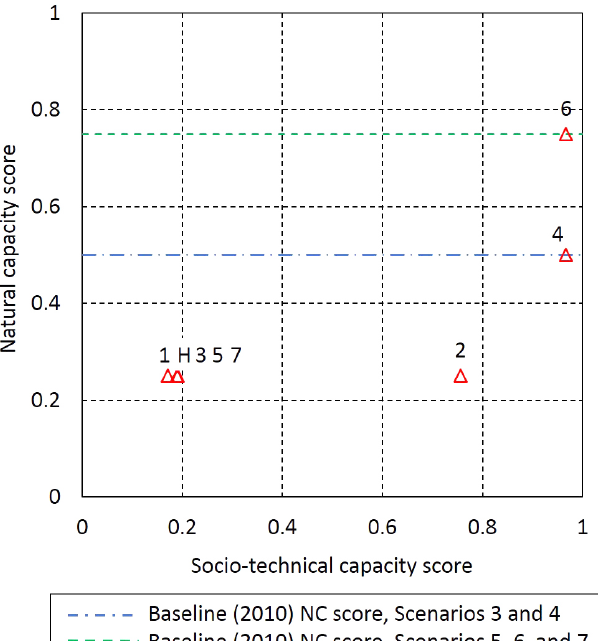
Fig. 6 . Resilience indicator scores following historic development (H) and future urban development Scenarios 1 to 7, Lucas Creek catchment.